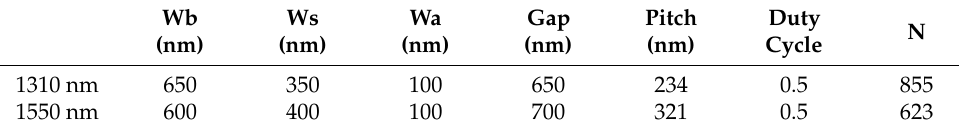
Figure 3. ( a ) The loss of WDM SWG in O − band with different parameters when transmitting C − band. ( b ) O − band coupling light field diagram. The light field map of the C-band (almost lossless output from the through to the end) when WDM is performed in the O − band. Table 1. O-band and C-band central wavelength SWG